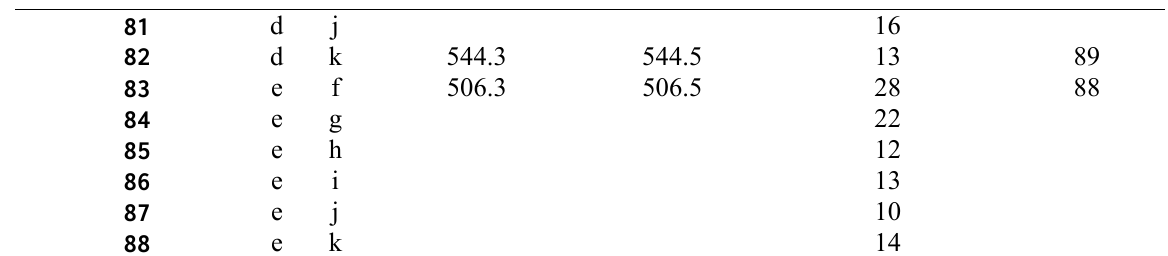
Table 3A. Characterization of members from library C (E